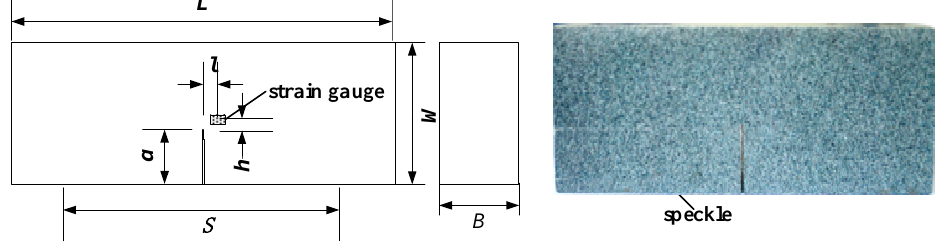
Figure 3. Geometric size of sample ( L = 64 mm, S = 60 mm, W = 28 mm, B = 14 mm, a = 7 mm, l = 2 mm, h = 2 mm).